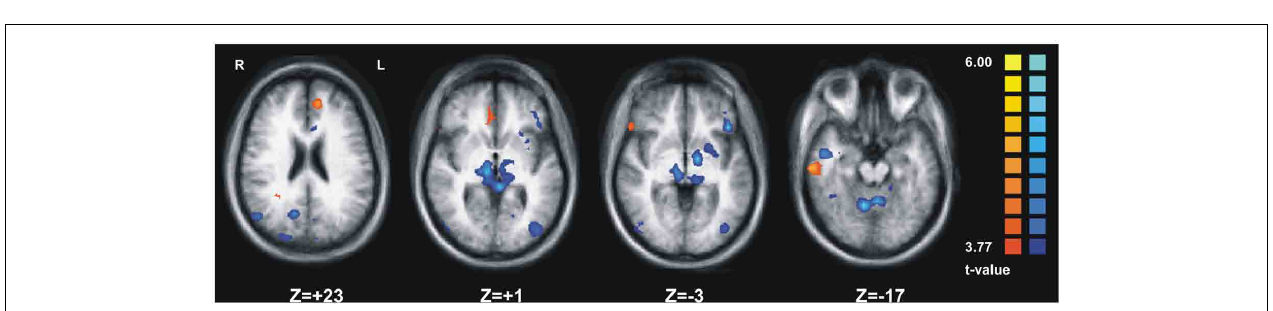
FIGURE 2 |The images to the left present the statistical maps reflecting the activation related to processing of visual information, regardless of the emotional content of the stimuli presented to the participants. The graphs on the left indicate the changes in BOLD signal (percentages) in the occipital poles relative to the onset of the visual